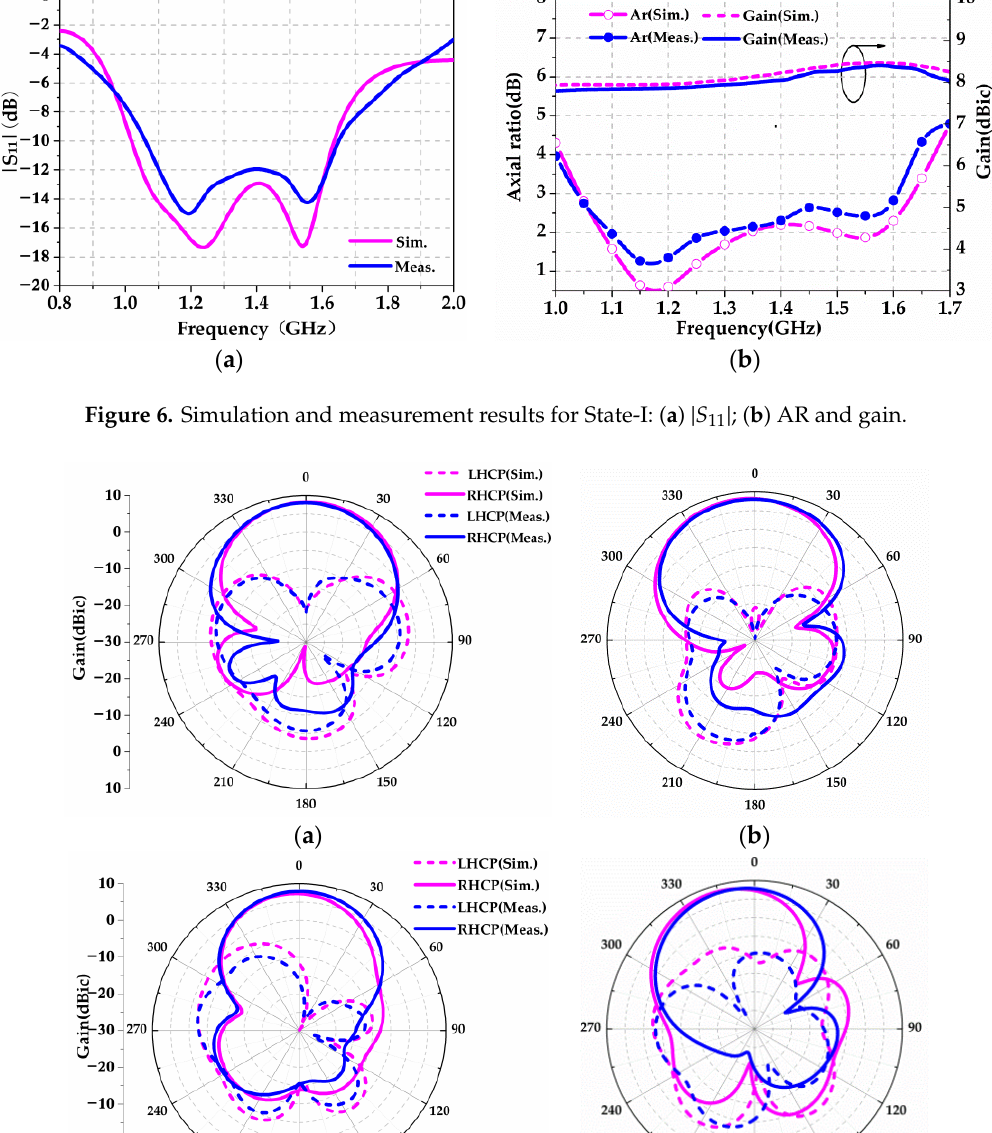
Figure 7. Simulated and measured radiation patterns for State-I: ( a ) xoz plane at 1.2 GHz; ( b ) yoz plane at 1.2 GHz; ( c ) xoz plane at 1.575 GHz; ( d ) yoz plane at 1.575 GHz.